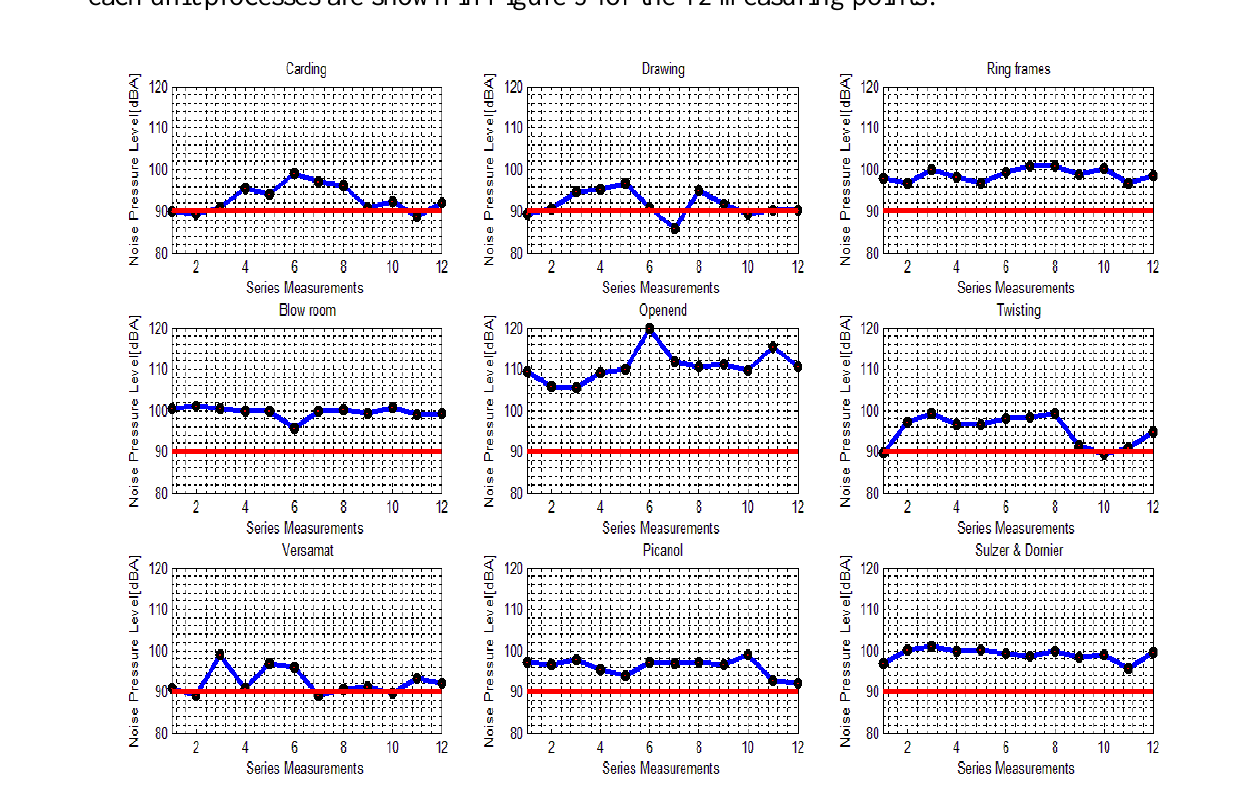
Figure 3. MATLAB-based analyzed data related to the two main sections of the KTM presented